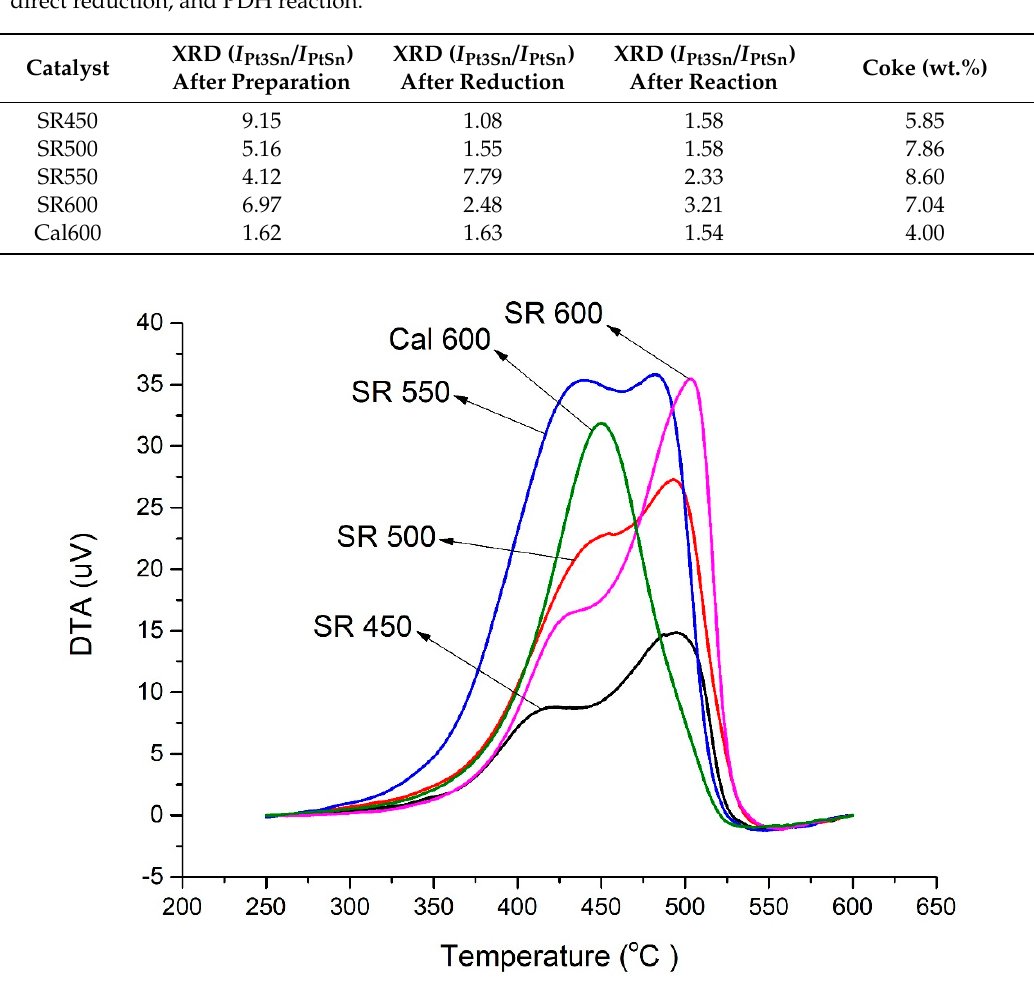
Table 1. Amount of coke and XRD peak ratios in the Pt 3 Sn and PtSn alloys after catalyst preparation, direct reduction, and PDH reaction.